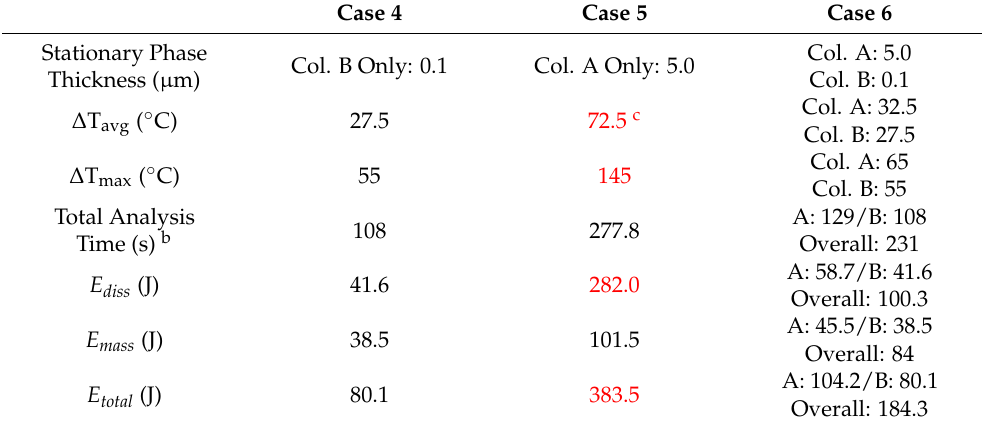
Table 4. Computed a values of energy consumption for temperature programmed Cases 4–6.